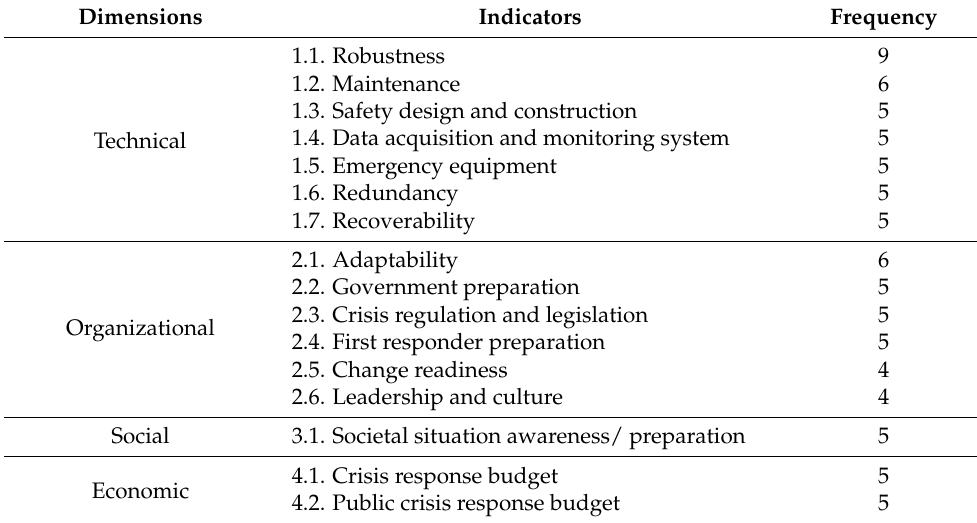
Table 3. Identified indicators of technical, organizational, social, and economic